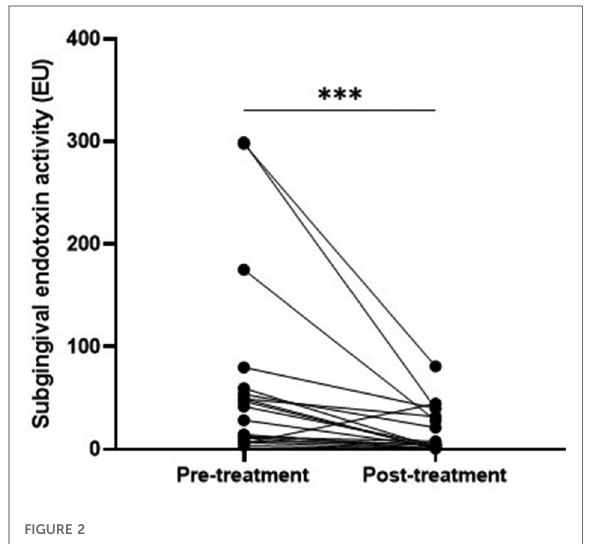
FIGURE 2 Comparison of subgingival endotoxin activities (EU/ml) in periodontitis patients before and after periodontal